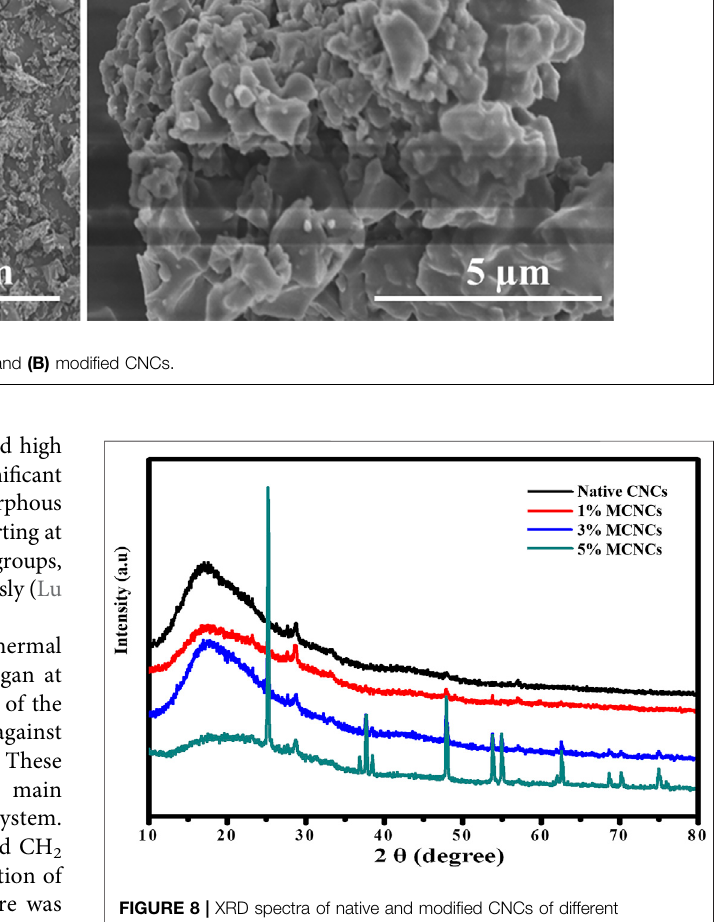
FIGURE 8 | XRD spectra of native and modi fi ed CNCs of different concentrations (1%, 3%, and